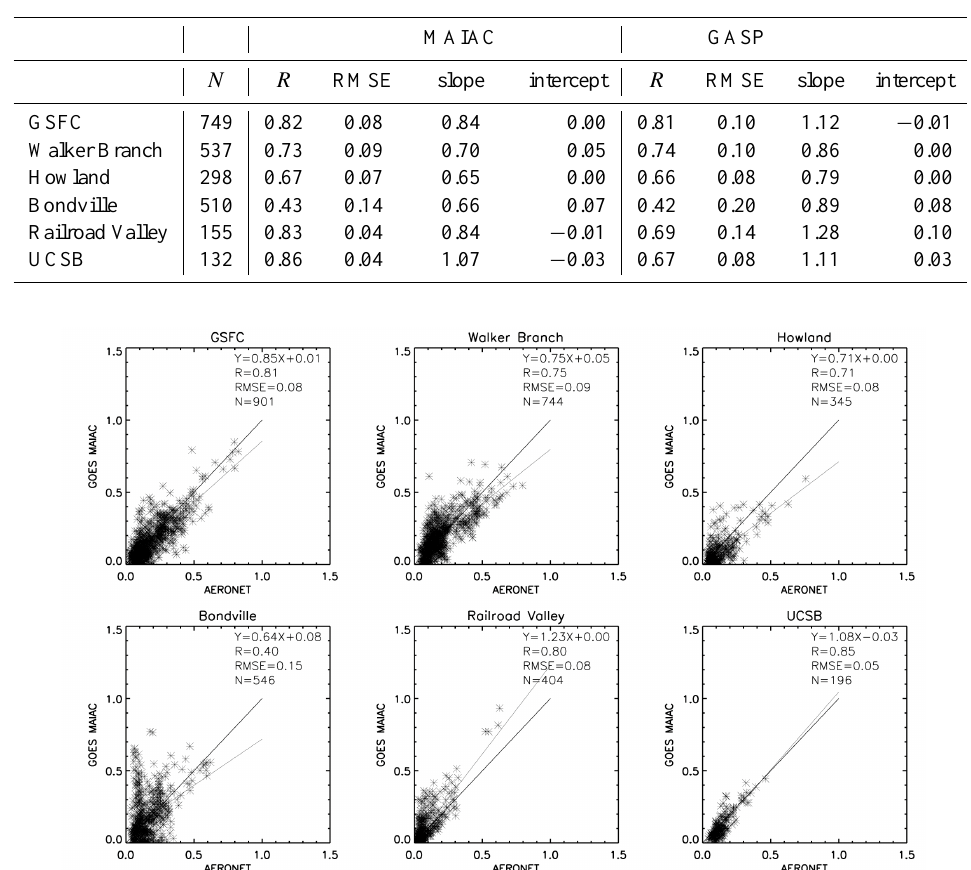
Fig. 5. Scatter plot of MAIAC vs. AERONET